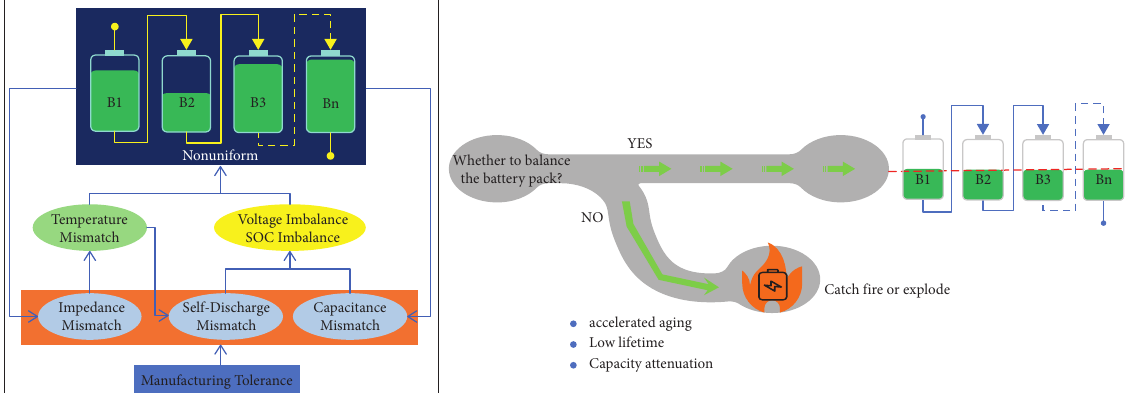
Figure 1: Sources of nonuniform, performance, and an equalization system design. B